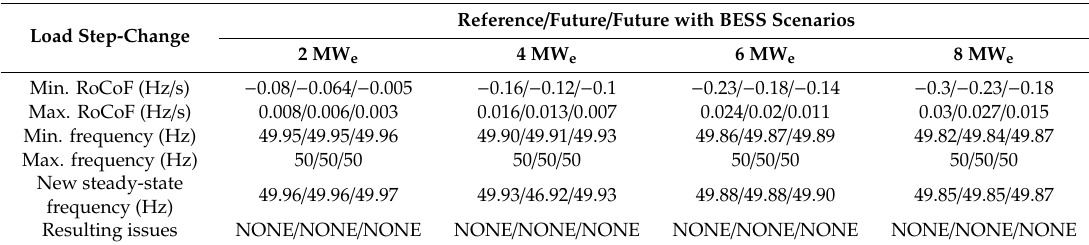
Table 6. Results for the best cases of the reference and future scenarios.